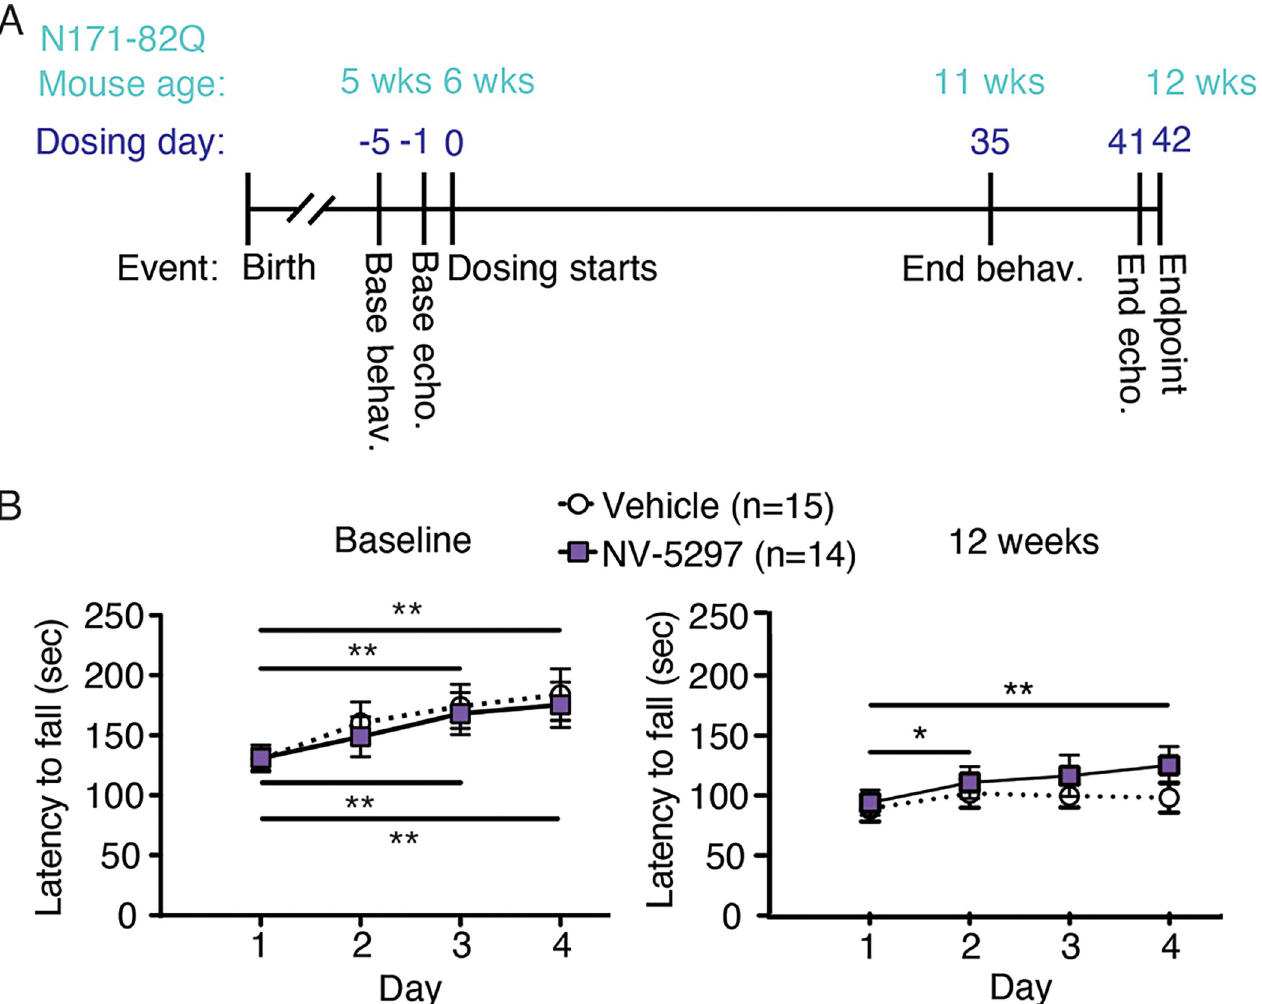
Fig 2. Daily oral dosing of NV-5297 over 6 weeks improves the motor performance in N171-82Q males. A Experimental timeline. 160 mg/kg NV-5297 is giving through oral dosing. B Latency to fall from the accelerating rotarod at baseline (6 weeks of age) and after 6 weeks of treatment (12 weeks of age) with either NV-5297 or vehicle. Statistical analysis identifies changes in performance within treatment groups over the course of the 4-day trial. Data are presented as mean ± SEM. � P � 0.05, �� P � 0.01 (2-way repeated measure ANOVA with Sidaks’s multiple comparison test).